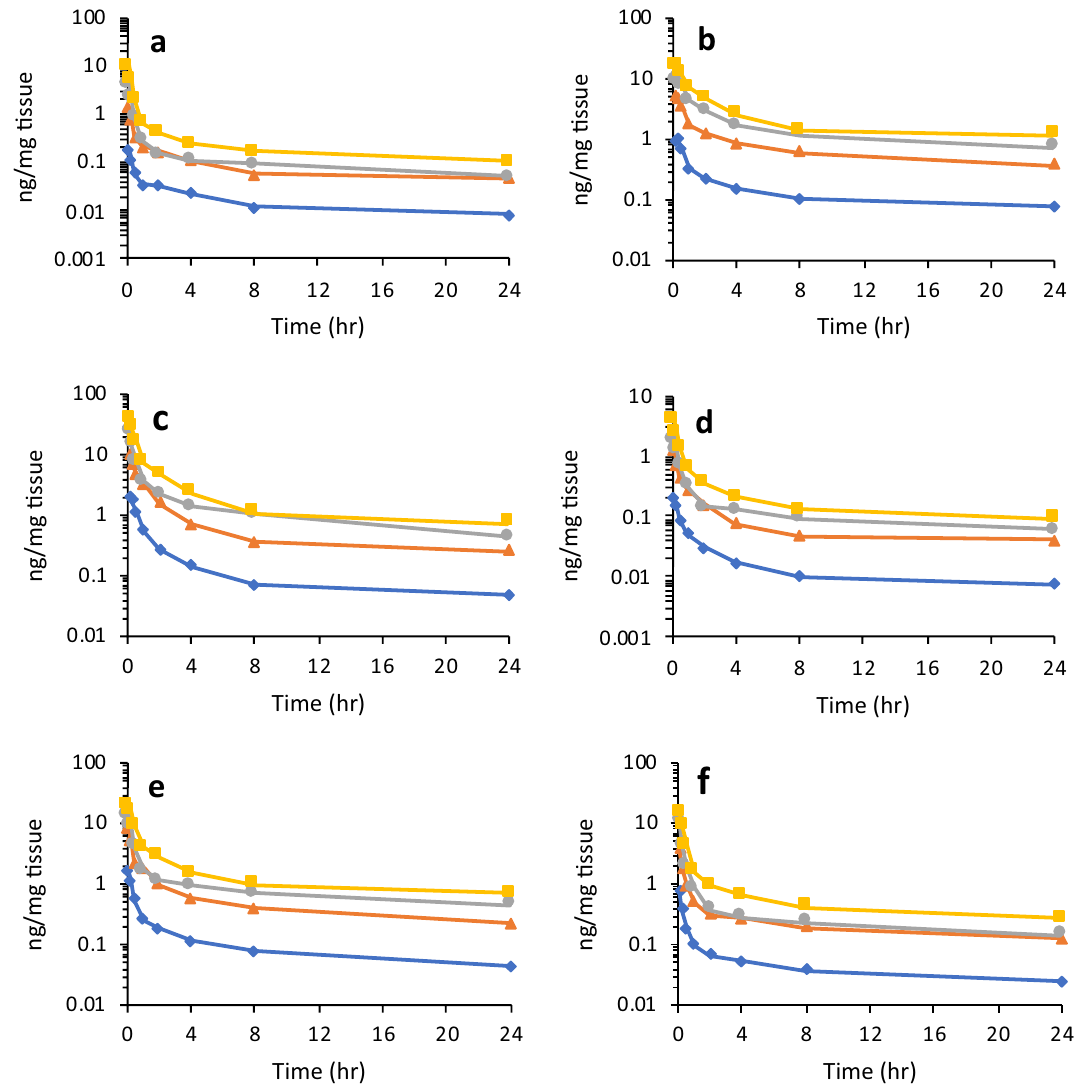
Figure 5. Mean concentration–time profiles of LLNL-02 in ( a ) brain; ( b ) liver; ( c ) kidney; ( d ) heart; ( e ) lung; ( f ) spleen following a single, intravenous administration of 1 (blue diamond), 5 (orange triangle), 10 (grey circle), or 20 (yellow square) mg/kg 14 C-LLNL-02 to male guinea pigs. Data are expressed as the mean of 6 animals ± the standard